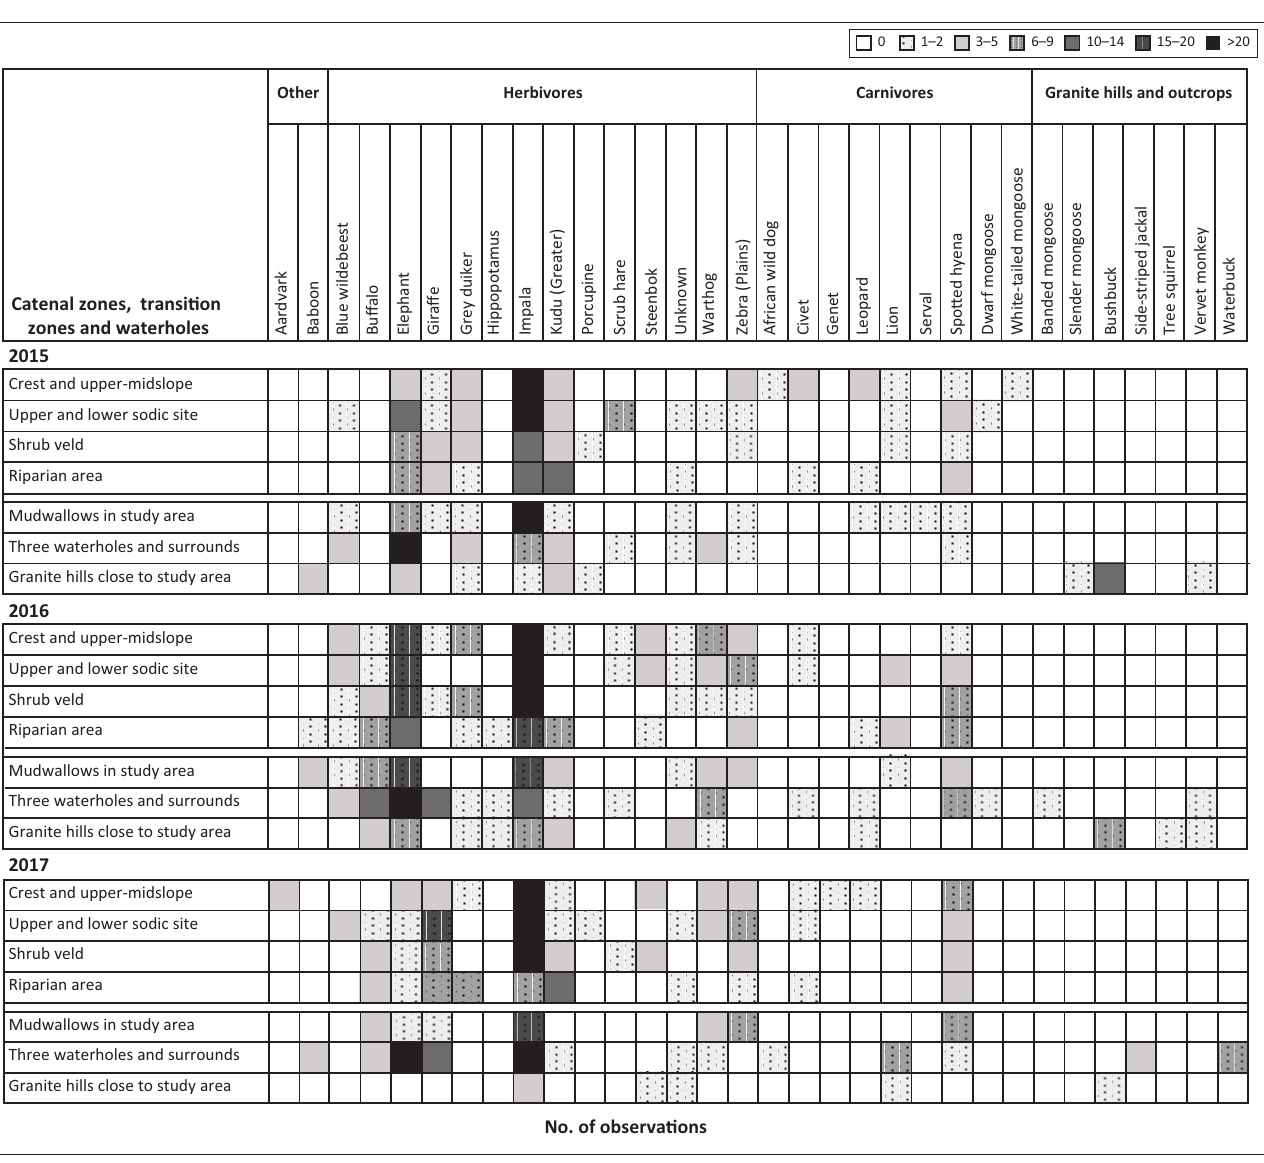
FIGURE 1: Number of events (observations) of each mammal species through camera trapping in the Southern Granite Supersite of Kruger National Park. Cameras were set up to represent each catenal zone from crest to drainage line, while waterholes and granite hills in the immediate vicinity of the catena were also covered. Results are indicated in class ranges in each catenal zone during the different survey periods. Species are grouped in the figure based on their feeding habits: other, herbivores, carnivores and the last seven species only occurred in surrounding areas but not on the catena